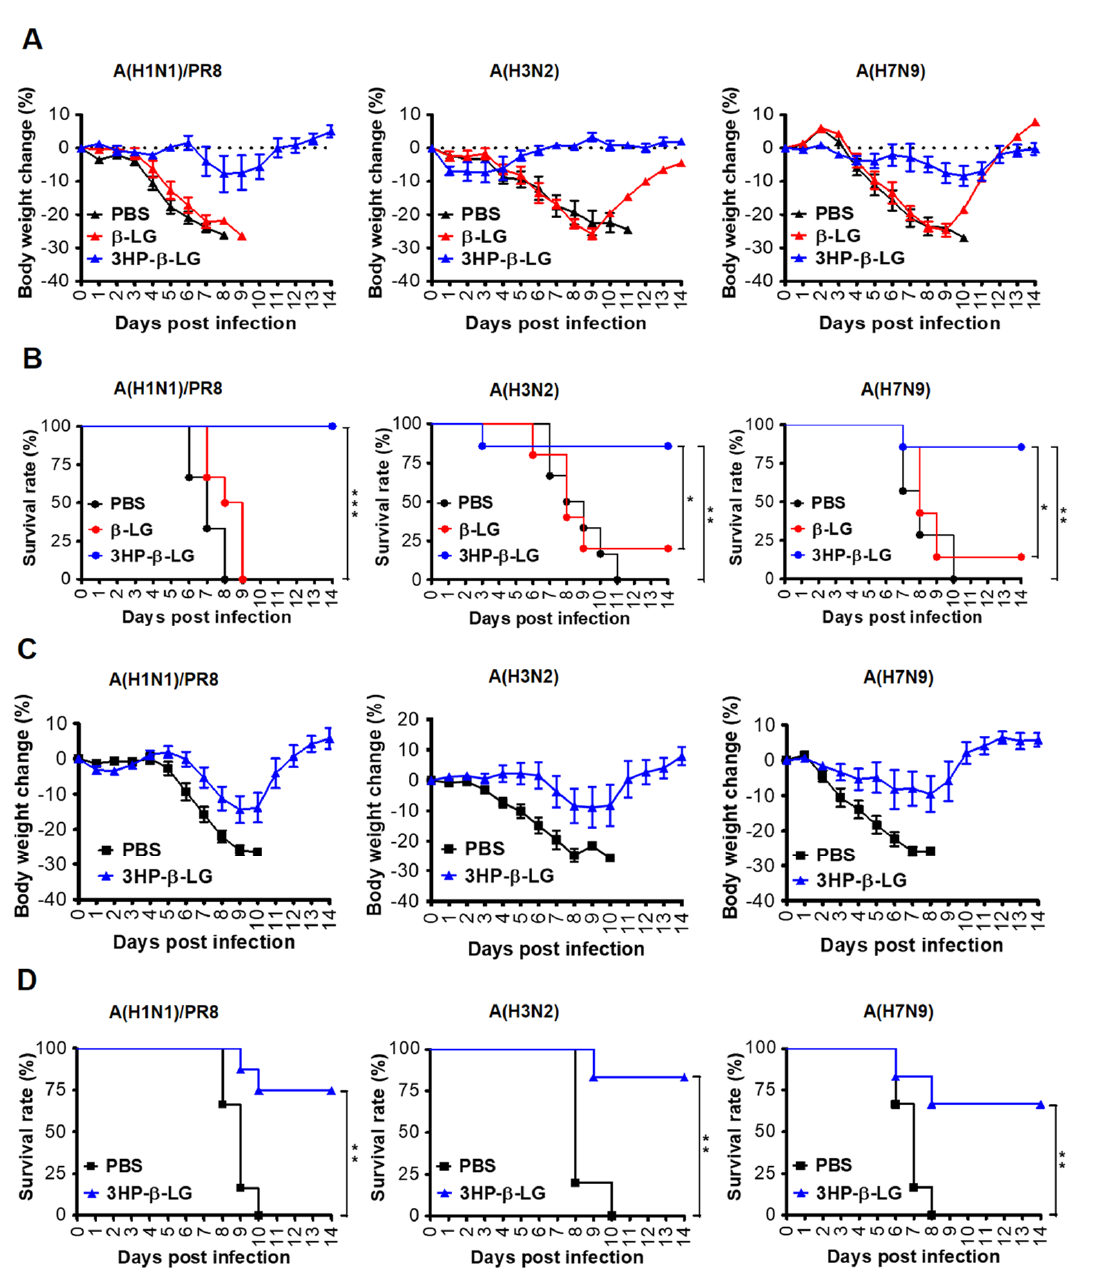
Figure 5. Protection of 3HP- β -LG against influenza virus infection in mice. ( A , B ) Prophylactic protection of 3HP- β -LG against influenza virus infection in mice treated with 3HP- β -LG 0.5 h before challenge with A(H1N1)/PR8, A(H3N2), or A(H7N9). ( A ) Bodyweight change (%) and ( B ) survival rate (%) of mice were recorded daily post-infection. *, **, and *** denote p < 0.05, 0.01, and 0.001, respectively. ( C , D ) Therapeutic protection of 3HP- β -LG against influenza virus infection in mice 4 h after challenge with A(H1N1)/PR8, A(H3N2), and A(H7N9). ( C ) Bodyweight change (%) and ( D ) survival rate of mice were recorded daily post-infection. Data are presented as mean ± SD.